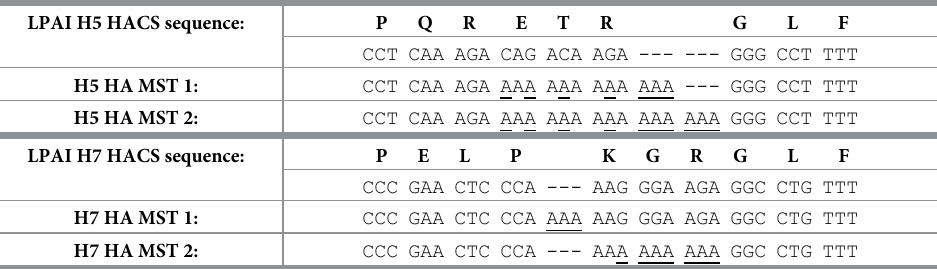
Table 1. Modified sequence tags used to retrieve reads spanning the hemagglutinin cleavage site. LPAI H5 HACS